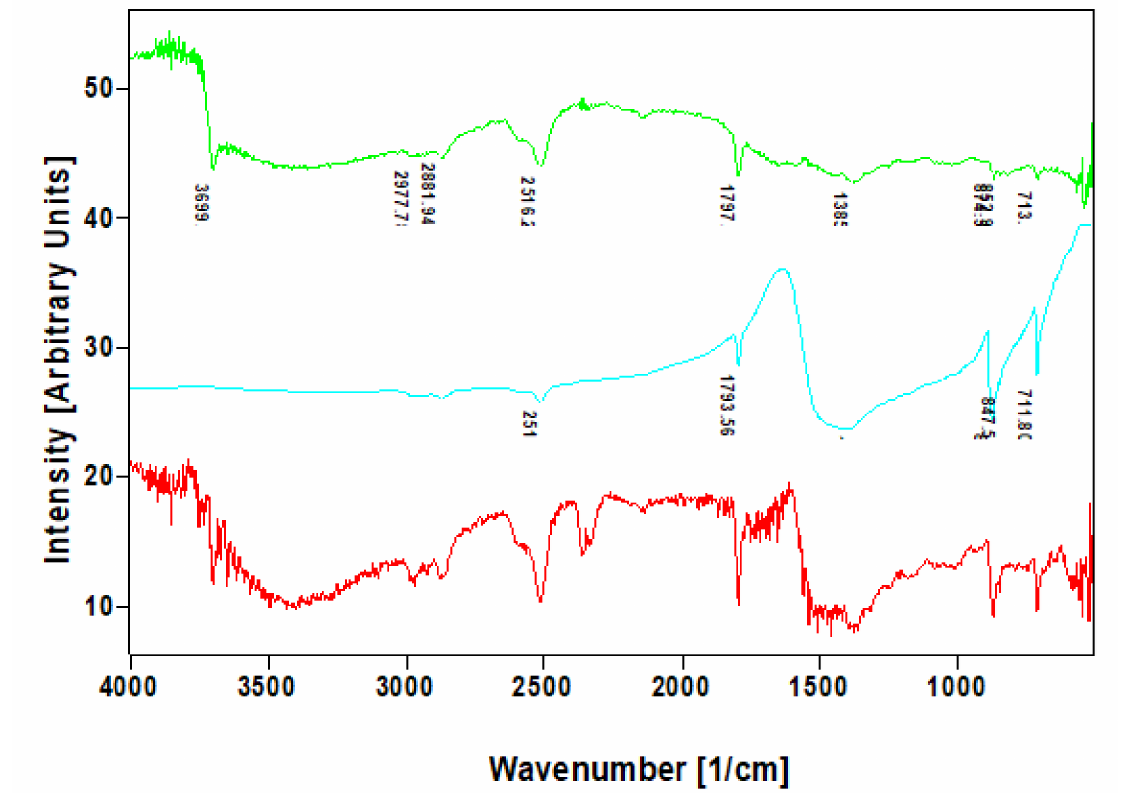
Figure 7. Comparative FTIR spectra of calcite standard (blue line) with that of nanocrystalline phases isolated from skeletal fibers of I. basta demosponges collected near Guam (USA) (red line) and in coastal waters of Australia (green